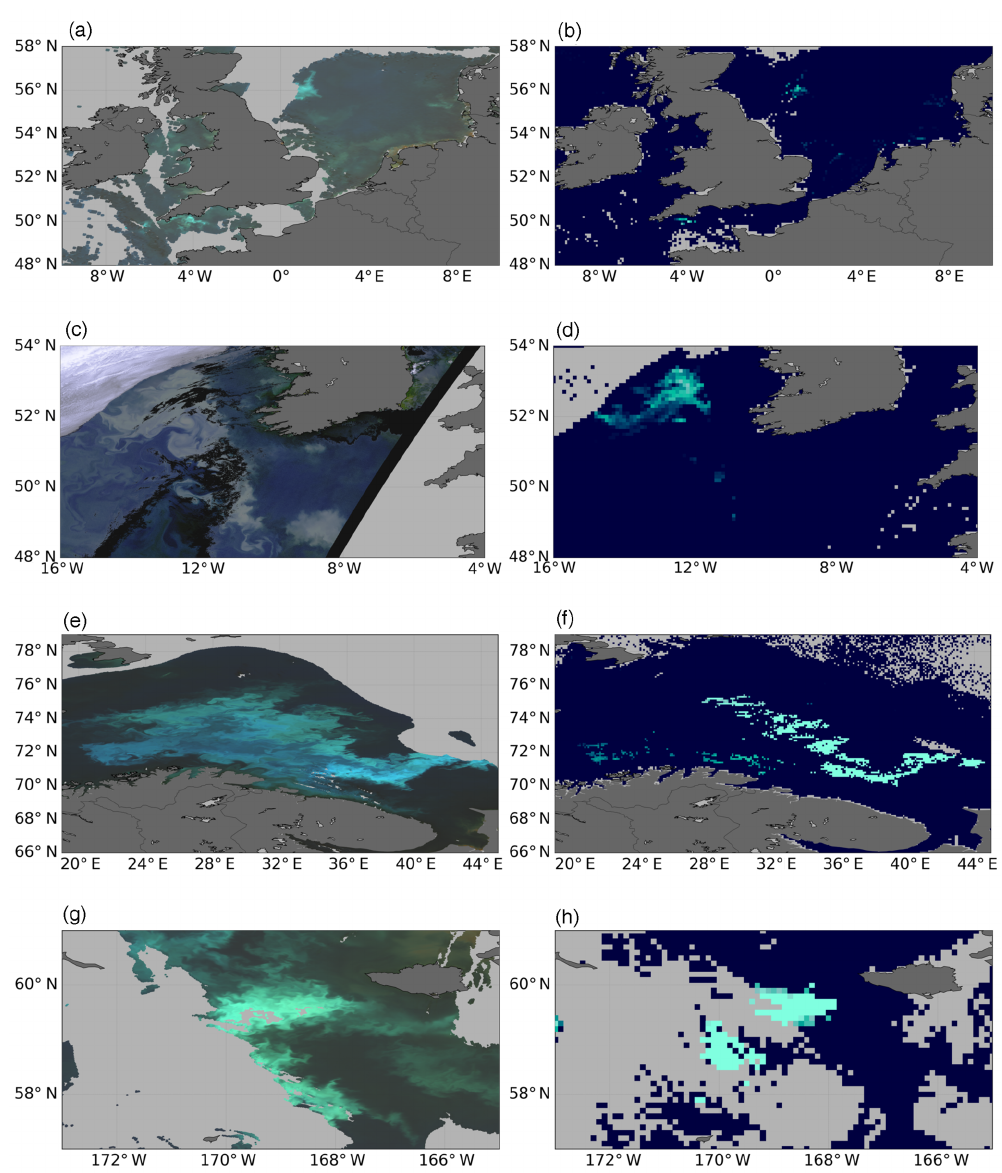
Figure 3. Examples of ocean-colour-derived red–green–blue (RGB) images of coccolithophore blooms matched to their filtered bloom product counterparts. Panels are as follows. (a, c, e, g) Level 2 RGB images for the North Sea and English Channel (SeaWIFS; 30 July 1999), North Atlantic and Irish Sea (MERIS; 23 May 2010), Barents Sea (MODIS; 17 August 2011) and Bering Sea (MODIS; 4 September 2014). (b, d, f, h) Matching, contemporaneous filtered bloom product composite for each location and date. Dark grey indicates land, and light grey indicates cloud, throughout. For bloom products, dark blue indicates that no bloom is present; lighter cyan colours indicate that a bloom is